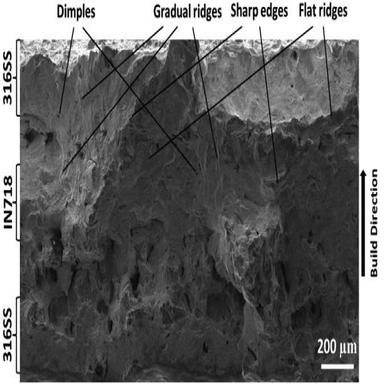
Fracture characteristics of 316SS/IN718/316SS SLM part.